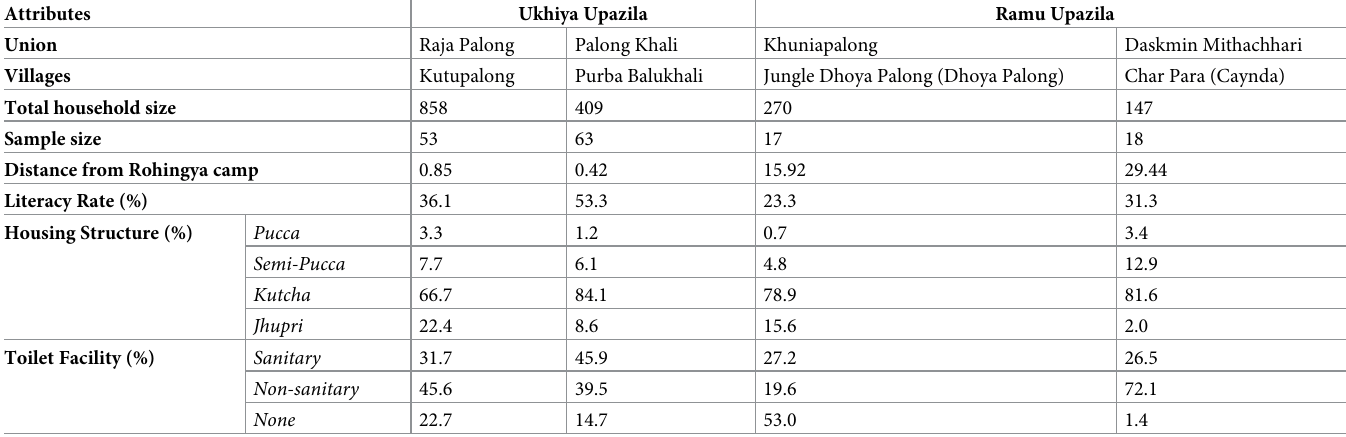
Table 1. Study villages, sample distribution, and basic household